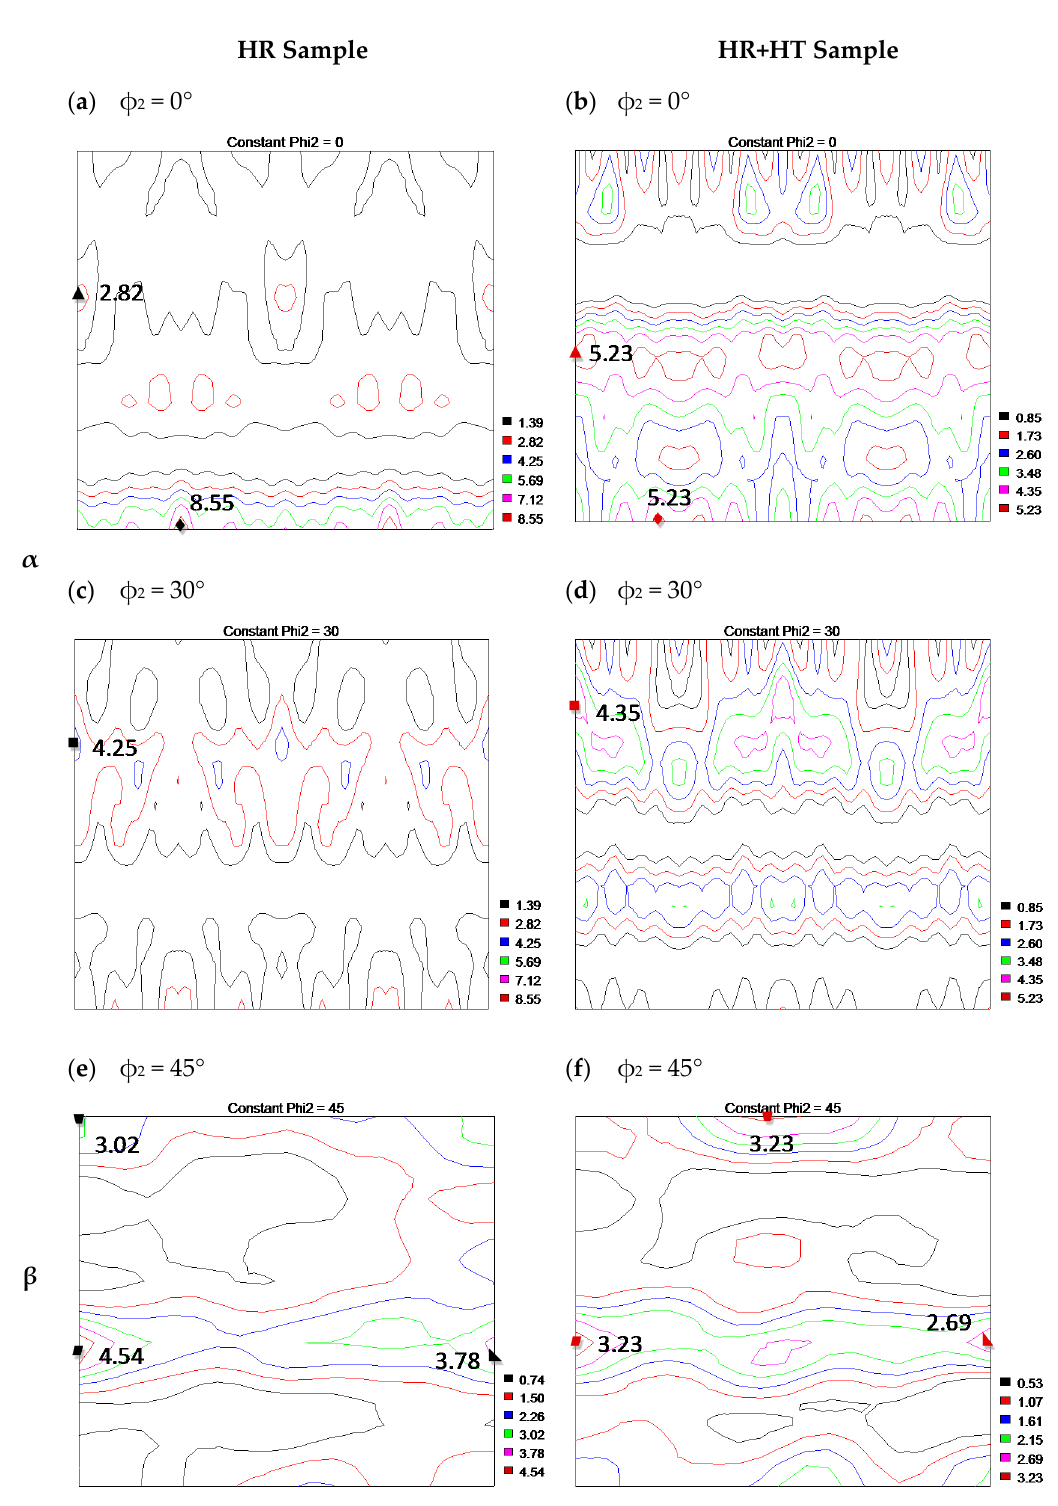
Figure 5. Orientation distribution function (ODF) plots of HR and HR+HT samples. ( a , b ): φ 2 = 0°; ( c , d ): φ 2 = 30°; ( e , f ): φ 2 = 45°.